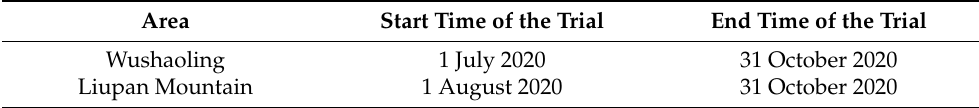
Table 5. Trial schedule. Area Start Time of the Trial End Time of the